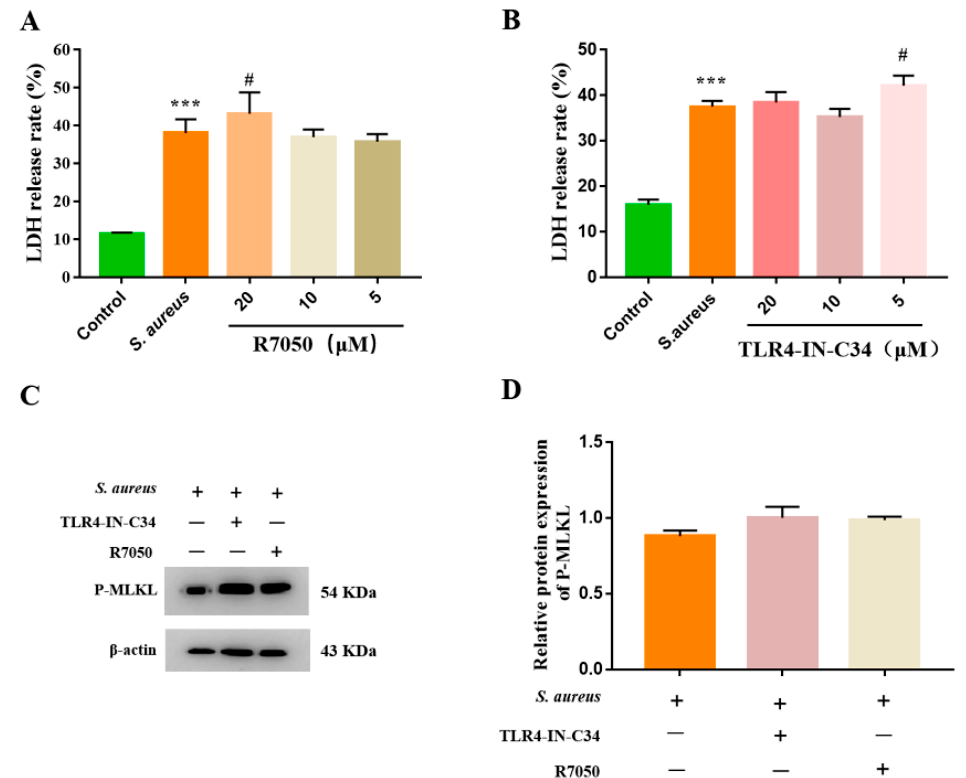
Figure 3. The death receptor signaling and TLR4 did not contribute to the initiation stage of gEEC necroptosis. gEECs were pretreated with the TNFR1 inhibitor (R7050) and TLR4 inhibitor (TLR4-IN- C34), respectively, for 2 h, then infected with 10 MOI S. aureus for 4 h. ( A , B ) The cytotoxicity was determined using a CytoTox96 ® non-radioactive cytotoxicity assay kit. ( C ) Western blot analysis of P-MLKL. ( D ) Protein abundance of P-MLKL, normalized with β -actin. *** p < 0.001 vs. control group, # p < 0.05 vs. S. aureus group.